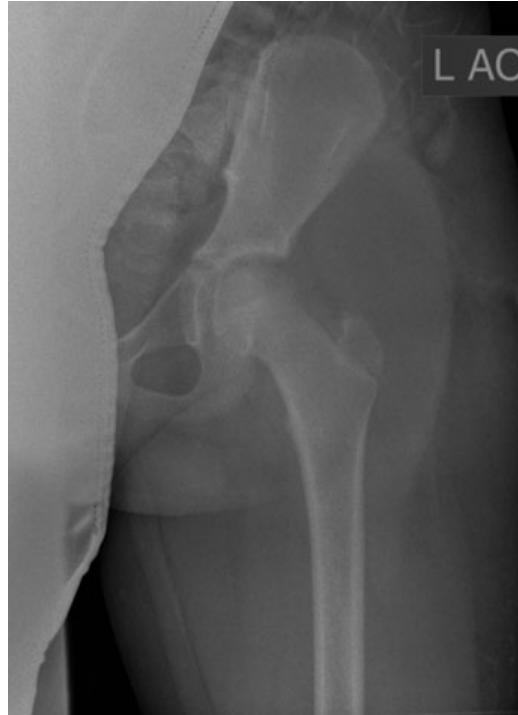
Fig. 5 Anteroposterior (AP) radiograph shows the concentric reduction of the hip after arthroscopic